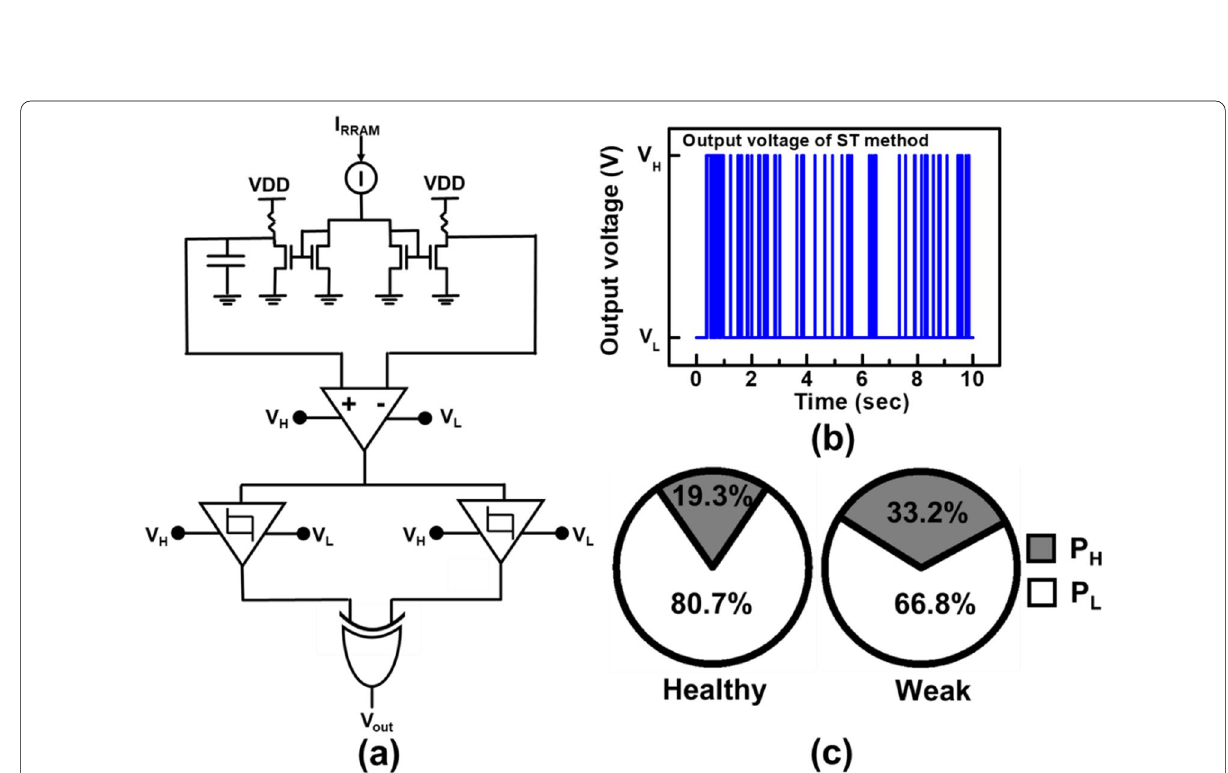
Fig. 9 a Schematic of ST detection circuit and b its voltage output. c Pie charts of output voltages on healthy/weak cells in ST method. More VL can be obtained in a healthy cell, which is probably with only one dominant